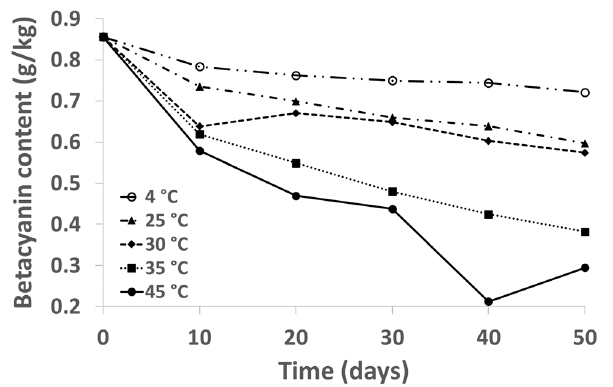
Figure 4. Evolution of the betacyanin content of samples of cactus pear juice at different temperatures during storage in the dark.